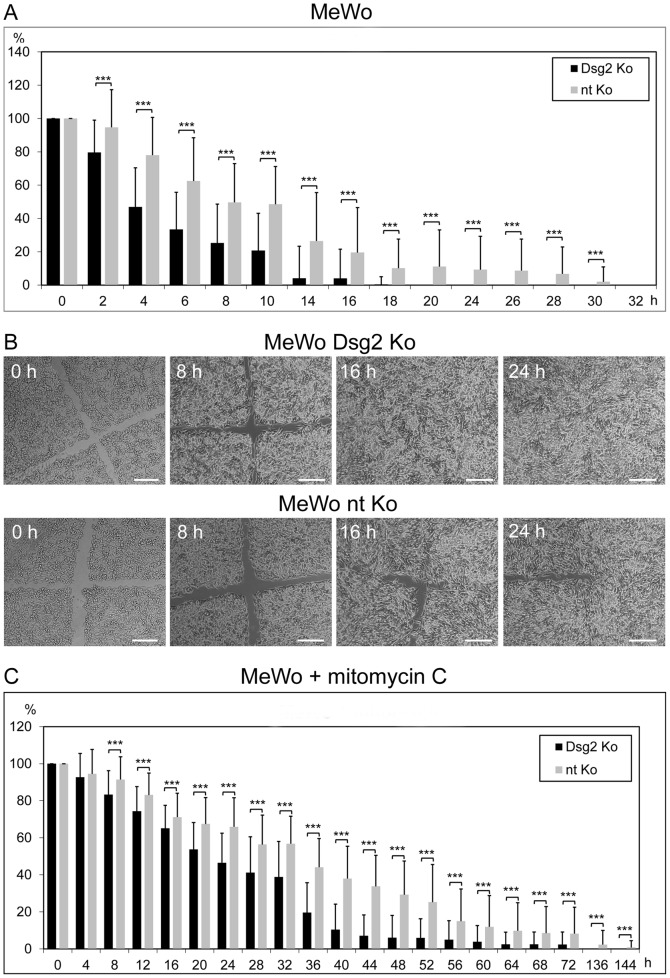
Scratch wounding assays demonstrating accelerated wound closure after Dsg2 depletion.Confluent monolayers of Dsg2-depleted (“Dsg2 Ko”) or non-targeting siRNA-treated (“nt Ko”) MeWo were wounded by scratching. (A) Bar diagram showing the percental width of the wound cleft at different time points after scratching. (B) Representative micrographs of wound clefts taken 0, 8, 16 and 24 h after scratching. Bars: 200 µm. (C) Scratch wounding experiment of Dsg2-depleted and non-targeting siRNA-treated MeWo cells that had been preincubated with mitomycin C to abolish proliferation. Bars: SD; * p≤0.05, ** p≤0.01, *** p≤0.001.